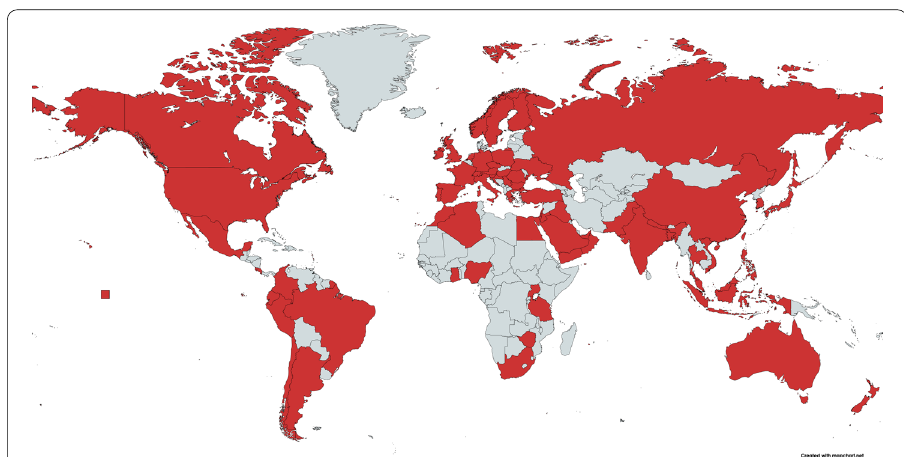
Fig. 2 Geographical location of authors, created using https:// mapch art. net/ world.